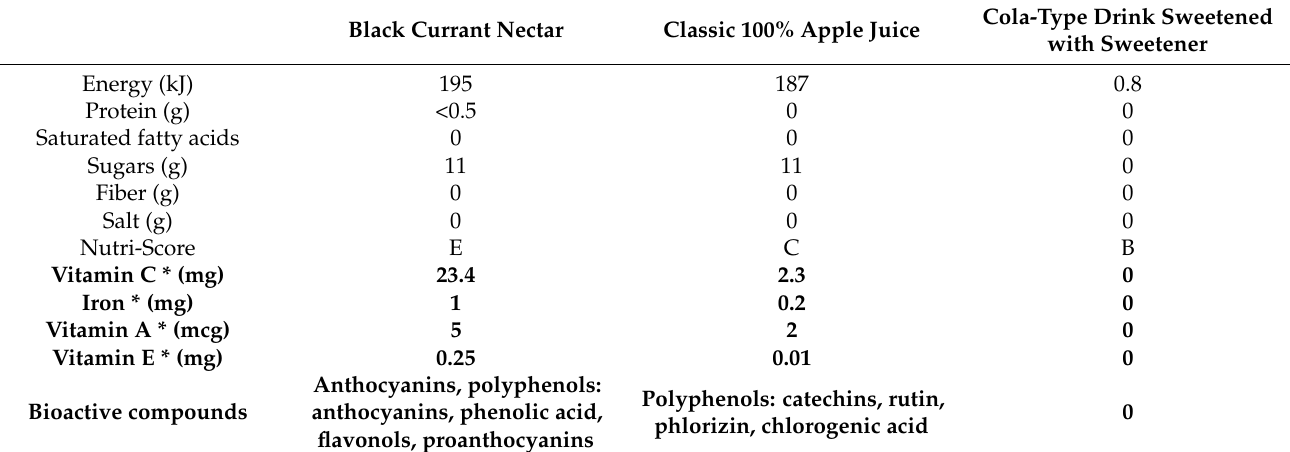
Table 3. Nutritional value of selected beverages (per 100 mL) and their Nutri-Score. Black Currant